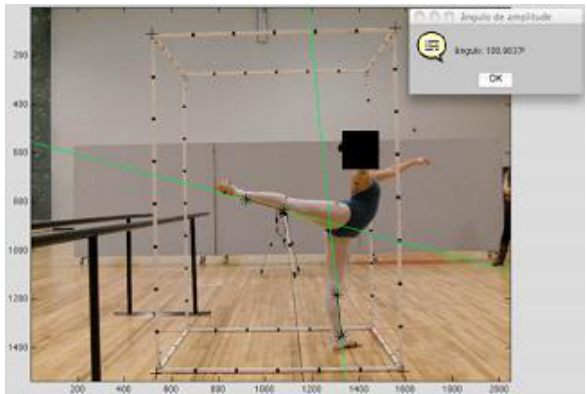
Figure 2. Example in how angle between body segments were obtained; asterisks represent the anatomical points marked for obtain the angle between body segments in this technical skill (arabesque). For each technical skill were marked different anatomical